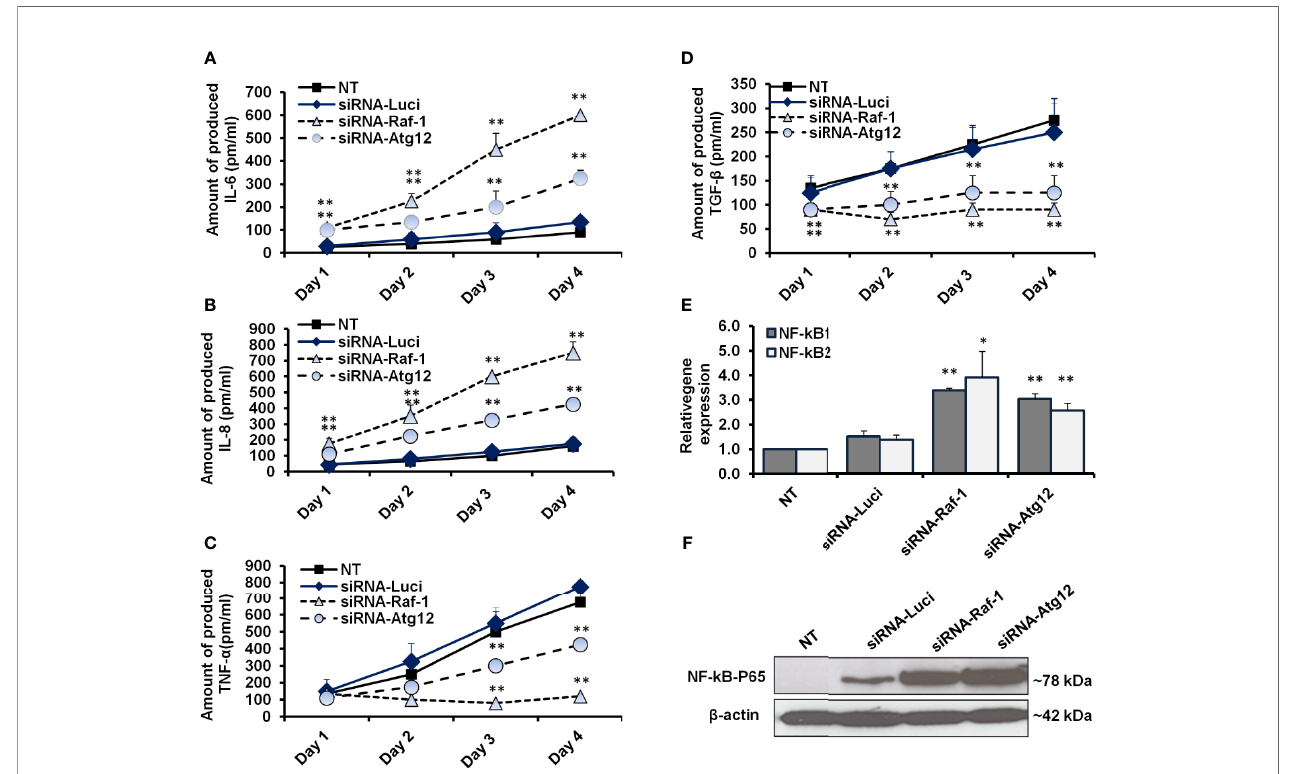
FIGURE 5 | Quanti fi cation analysis of proin fl ammatory cytokines and NF-kB effectors in siRNA-transfected cells. (A, B) The concentration of produced IL-6 and IL-8 (pm/ml) in the fl uids media of MCF-7 that were transfected with siRNA against Raf-1 or Atg12 compared with the control-transfected cells, n = 4. (C, D) Level of produced TNF- a and TGF- b (pm/ml) from MCF-7 cells that were transfected with the indicated siRNAs compared with the control-transfected cells, n = 4. Error bars indicate the SD of four biological replicates. (E) Relative gene expression of NF-kB1 and NF-kB2 in transfected cells upon 48 h posttransfection in comparison with control-transfected cells that quanti fi ed by qRT-PCR. Error bars indicate the SD of three independent experiments. (F) Immunoblotting analysis of the conjugated NF-kB – P65 in transfected MCF-7 cells using WesternBreeze Chromogenic Kit. b -Actin served as a loading control. Data are representative of three independent experiments. A Student ’ s t-test analysis was performed. * p ≤ 0.05 and ** p ≤